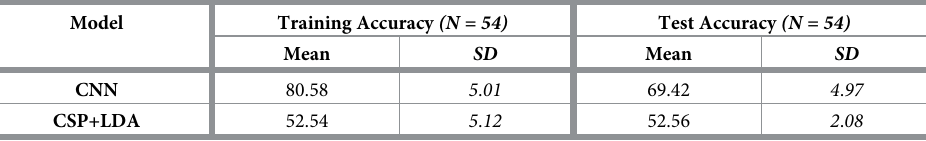
Table 1. Comparison between training and test accuracies of CNN and CSP+LDA